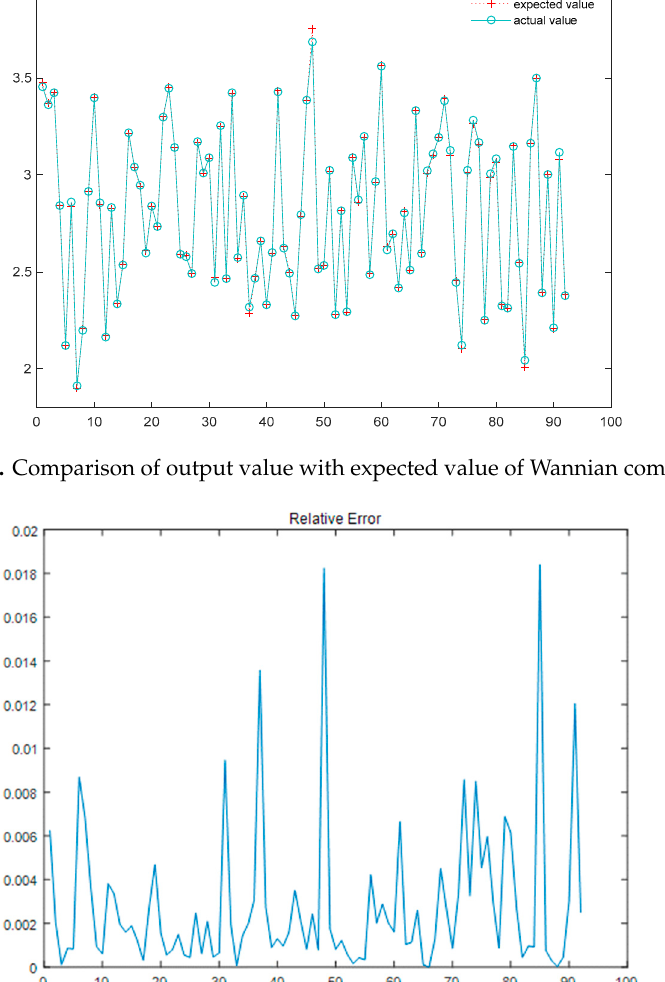
Figure A5. Comparison of output value with expected value of Hugong community. Figure A6. Relative error variation of Hugong community. 0